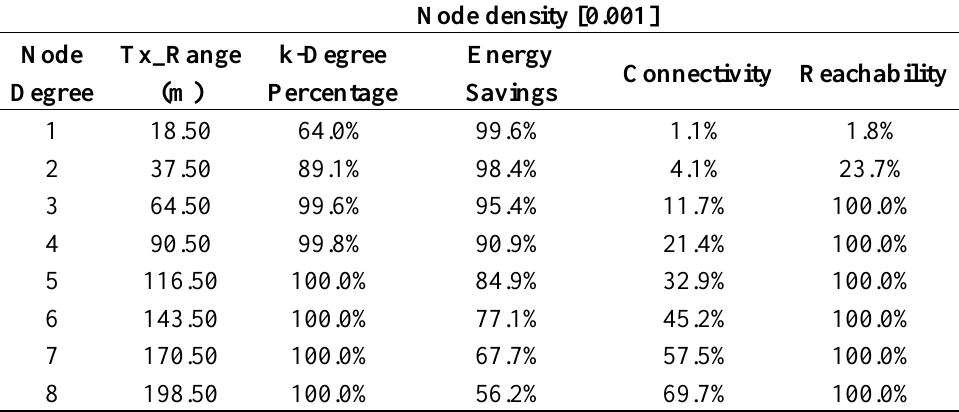
Table 2. The numerical evaluation results for a network with a node density of 0.001 nodes/m 2 .